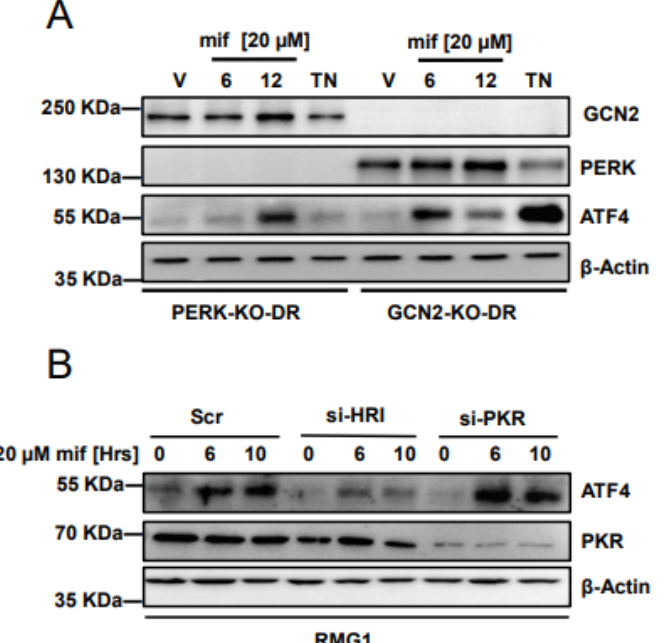
Figure 6. Mifepristone activates the HRI kinase pathway. ( A ): Mouse embryonic fibroblast generated from PERK knockout mice (PERK-KO-DR) and mouse embryonic fibroblast generated from GCN2 knockout mice (GCN2-KO-DR) were incubated with 20 µ M of mifepristone for 6 and 12 h. Vehicle (V) and TN (2 µ M-Tunicamycin) treatments were performed for 12 h and lysates were probed with indicated antibodies. β -actin was used as loading control. ( B ): RMG1 cells were transiently transfected with scrambled (Scr) and small interfering RNAs (siRNAs) targeting HRI (si-HRI) and PKR (si-PKR) for 48 h followed by treatment of 20 µ M of mifepristone for 6 and 10 h. Protein lysates were then subjected to immunoblotting with indicated antibodies. β -actin was used as loading control. All experiments were performed in at least two biological replicates. Uncropped immunoblots can be found in Figure S12.